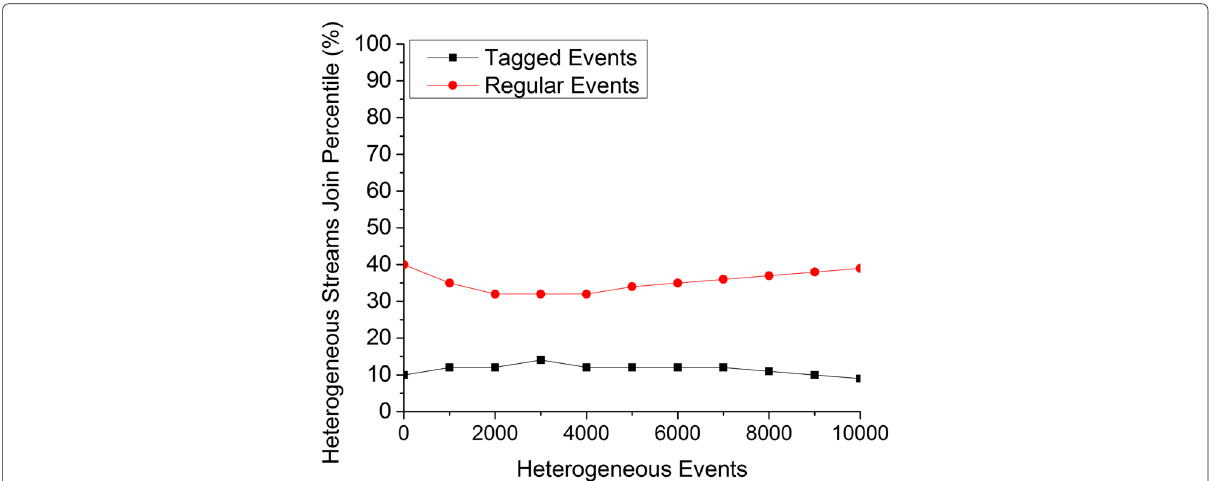
Fig. 9 Heterogeneous Streams Join Computing